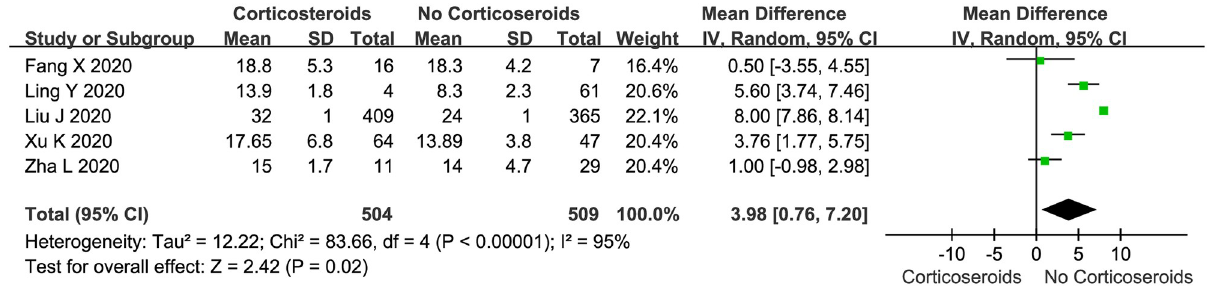
Fig 4. Corticosteroid vs. no corticosteroid treatment: Viral clearance time (days).